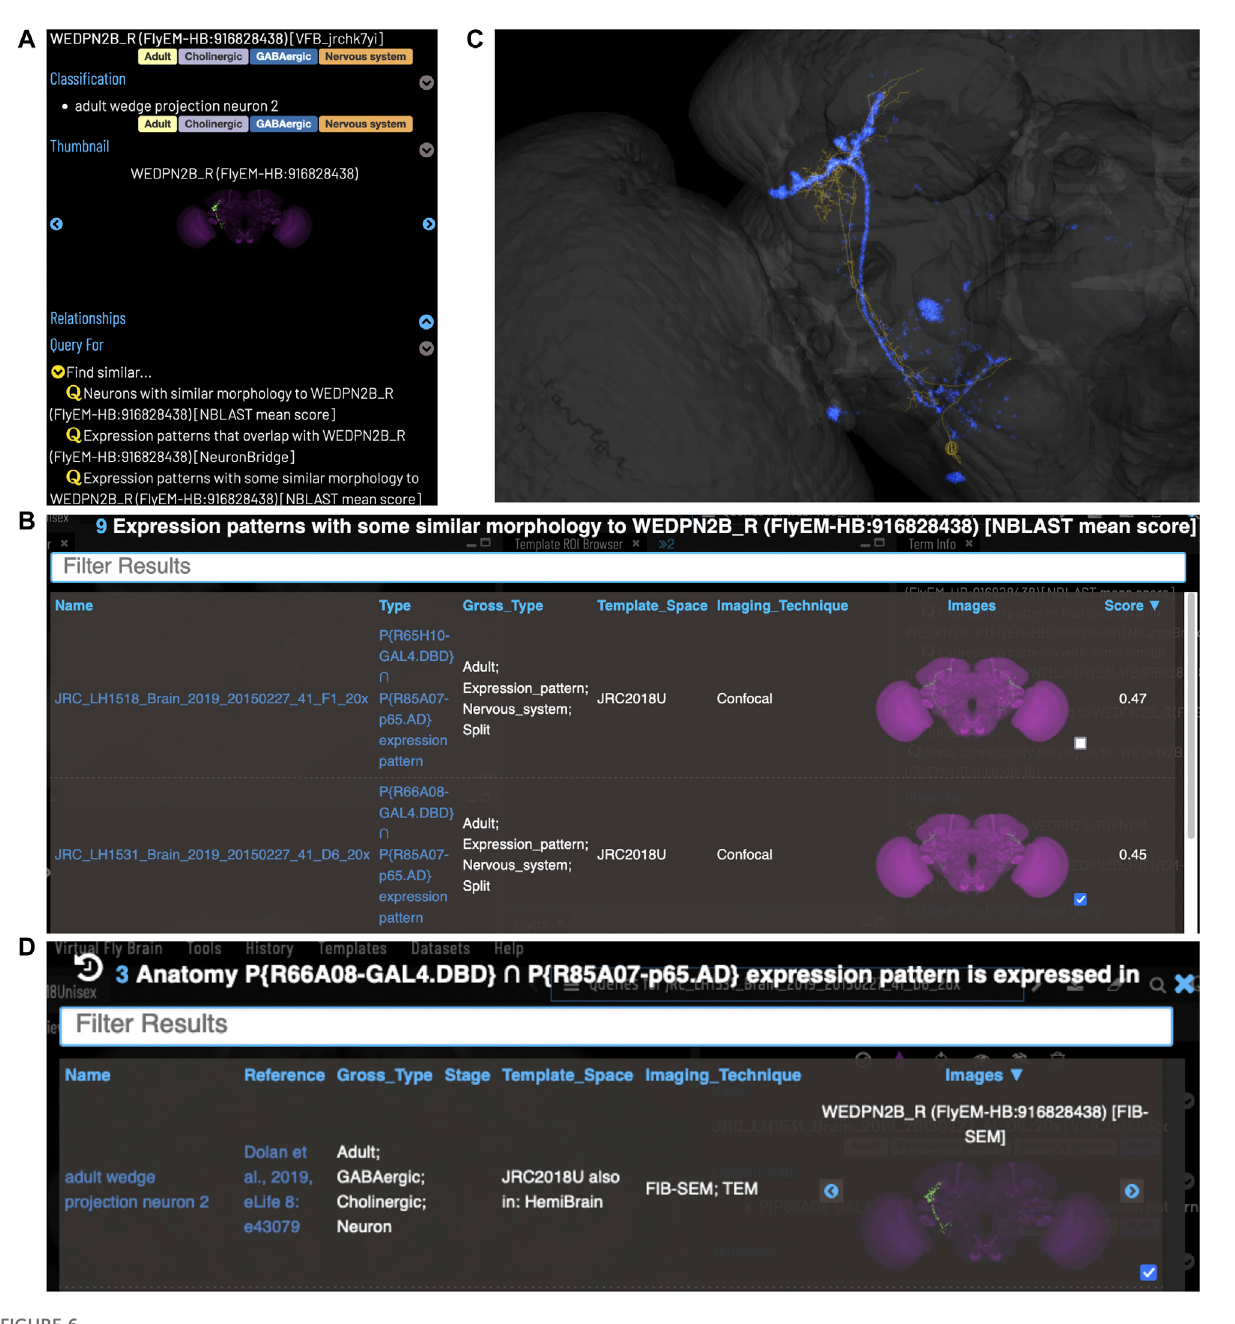
FIGURE 6 Identifying Split-GAL4 combinations that potentially target a query neuron. (A) TermInfo for a neuron, “ WEDPN2B_R ” , type “ adult wedge projection neuron 2 ” (WEDPN2), from the hemibrain dataset. This neuron will be used for an NBLAST search. (B) NBLAST query results showing Split-GAL4 driver line results and NBLAST scores. The third result (with the checked tickbox) was selected for further investigation (panels C and D). (C) Image of the query neuron skeleton (yellow) and Split-GAL4 expression pattern point cloud (blue) overlap. (D) A search for neuron types that this Split-GAL4 combination is known to target, curated from the literature, fi nds the type of the neuron used for the NBLAST search (WEDPN2), supporting the NBLAST query result in this